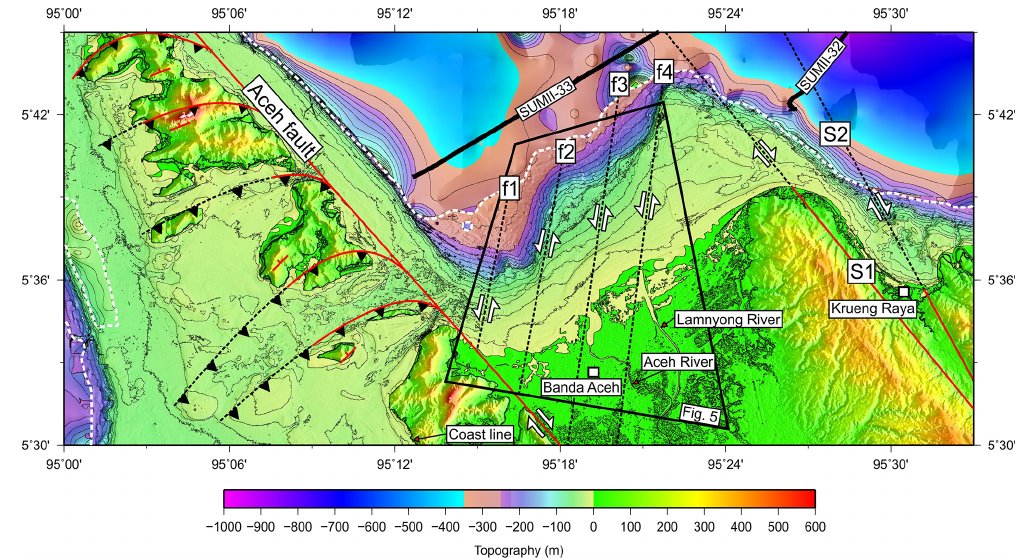
Figure 4. Topographic map of the northern tip of Aceh province. Figure 5 in a closeup of the trapezoidal box viewed from the northeast to southwest.